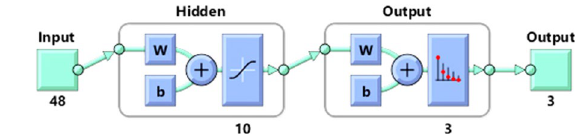
Fig. 6 DL neural network for the proposed